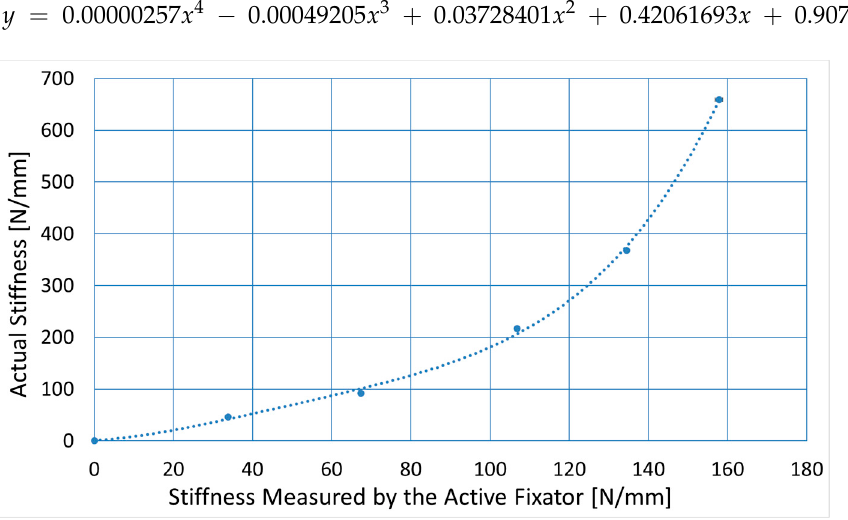
Figure 6. The relation between the stiffness of the experimental defect measured by the active fix- ator and the actual stiffness measured by a universal testing machine. Each point represents the average of 10 loading cycles. All standard deviations were lower than 2 N/mm. The coefficient of determination (R2) was >